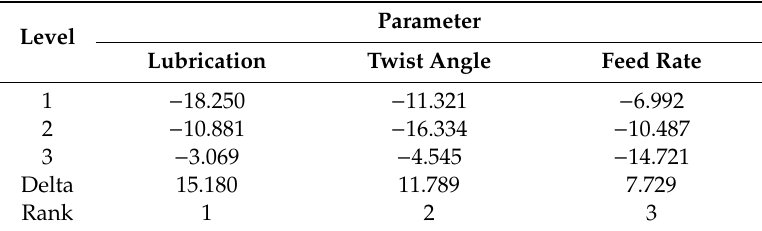
Table 8. Main response table of correlation to the ideal solution ( C u )